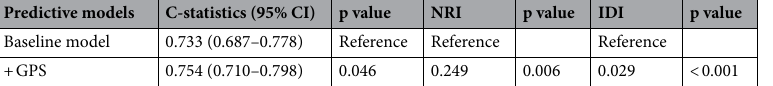
Table 4. Discrimination of each predictive model for all-cause mortality using C-statistics, NRI and IDI. Baseline model included age, sex, hypertension, diabetes mellitus, atrial fibrillation, New York Heart Association functional class. CI confidence interval, GPS Glasgow Prognostic Score, IDI integrated discrimination improvement, NRI net reclassification improvement.